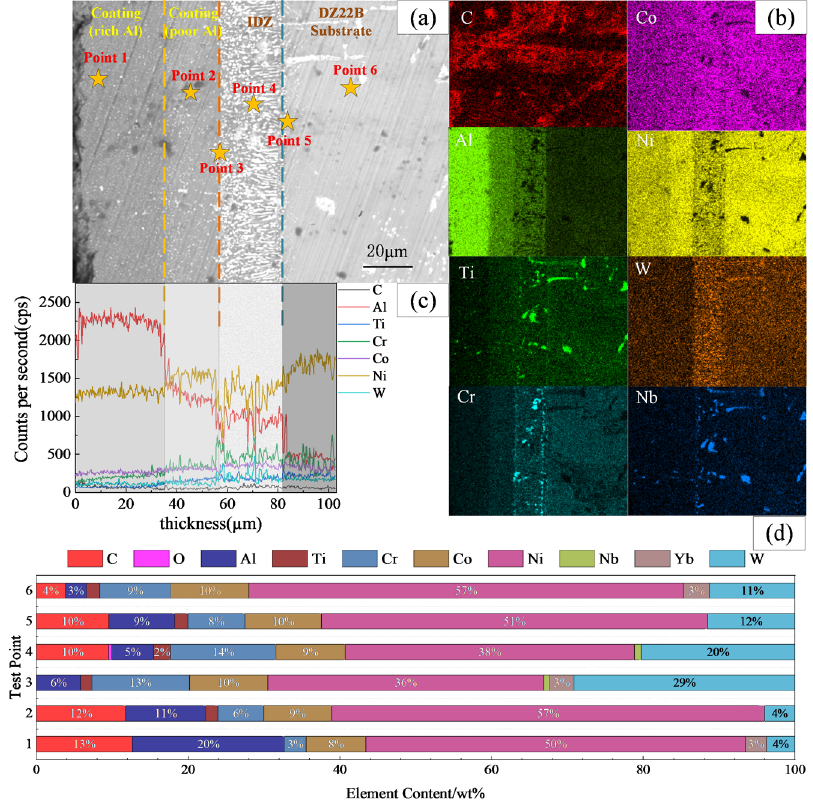
Figure 2. Characterization of turbine blade cross-section. ( a ) SEM morphology under backscattering. ( b ) EDS mapping of ( a ); ( c ) distribution of elements after line scan along the depth direction; ( d ) mass fraction of elements from the test points in ( a ).